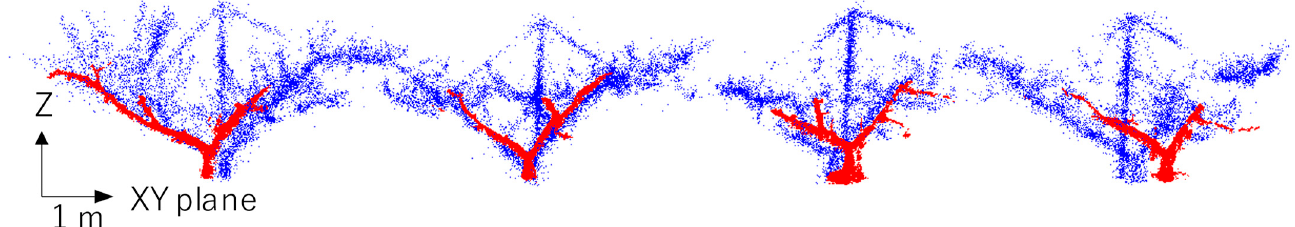
Figure 7. Point cloud cross-section of peach tree (red points: UAV-SfM point cloud; blue points: 3D lidar SLAM).